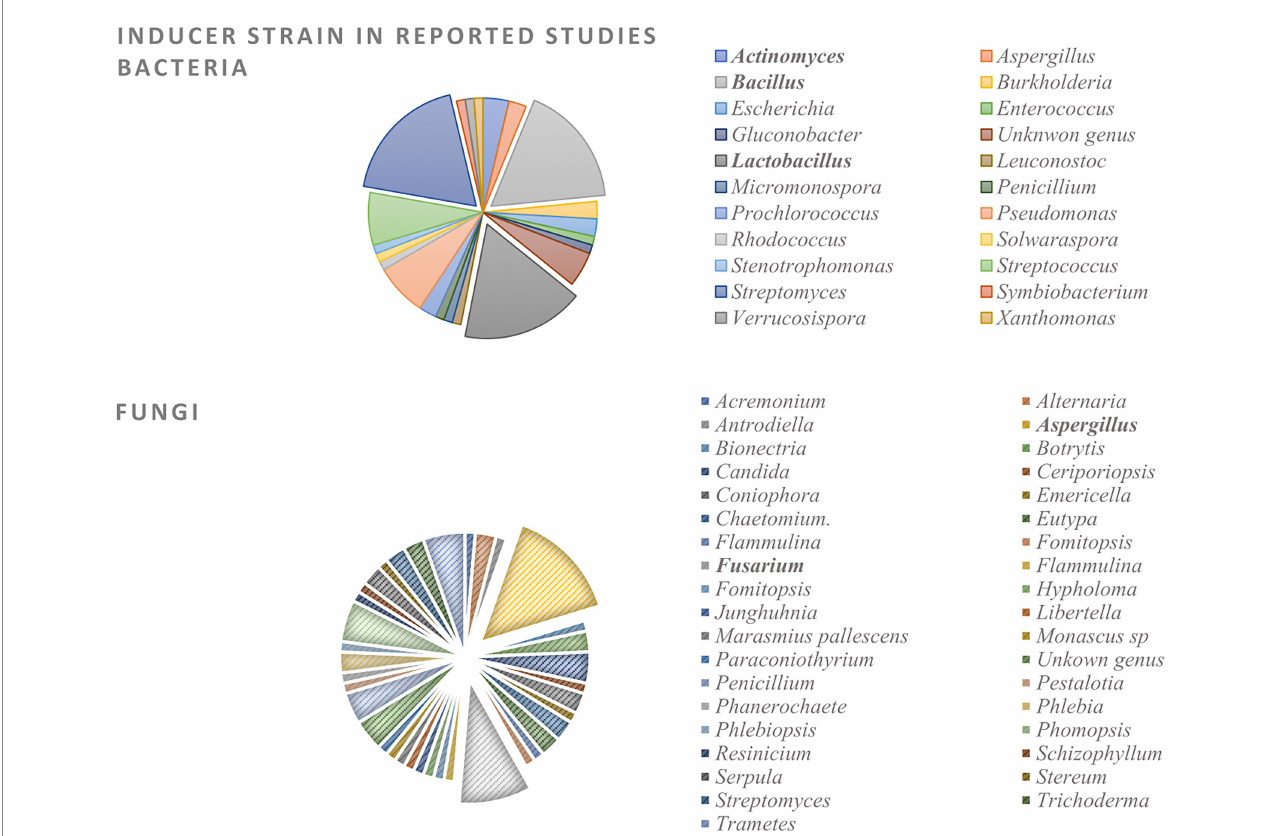
FIGURE 7 Bacteria and fungi inducer strains in reported co-culture studies from 1978 to